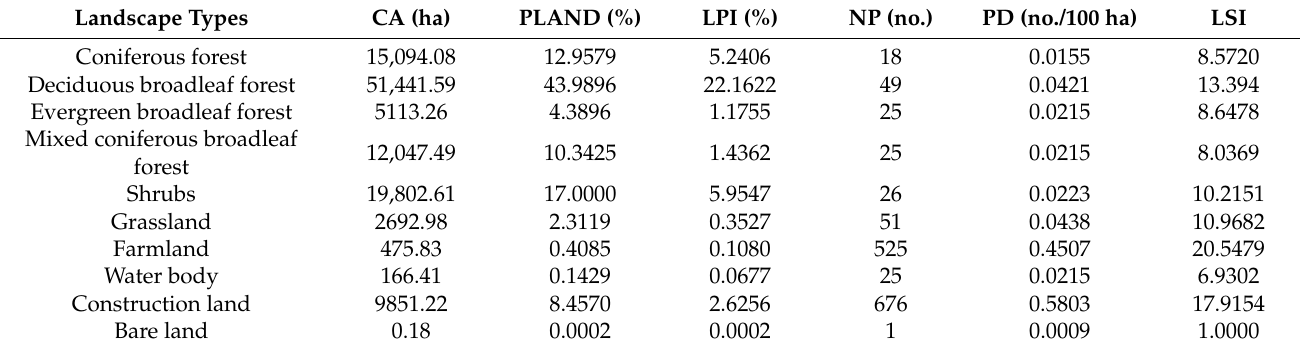
Table 5. Landscape pattern distribution characteristics of different landscape